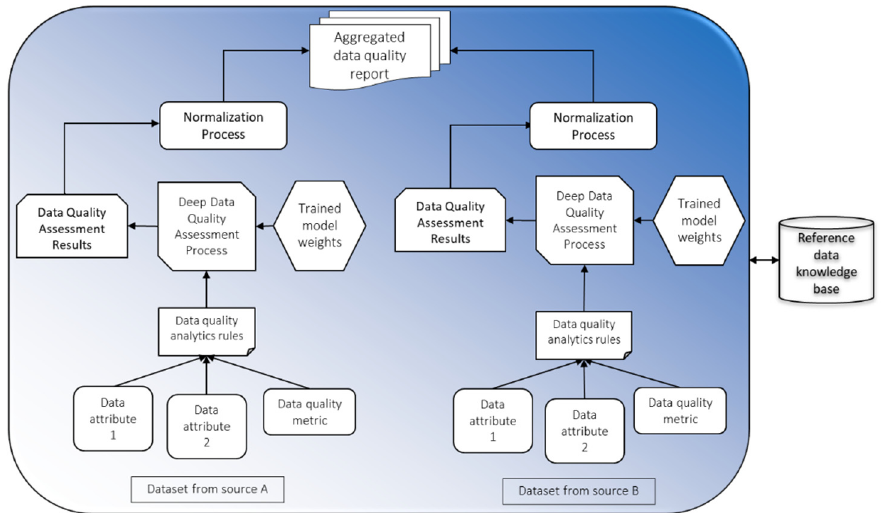
Figure 4. Assessment of aggregated data.